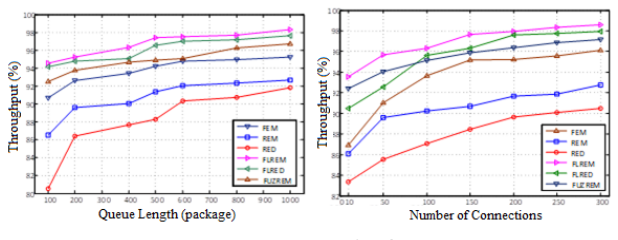
Figure 18. Throughput of AQM mechanisms In all cases, the RED mechanism always has the lowest throughput and the FLREM mechanism always has the highest throughput. This result is due to FLREM mechanism which converges criteria when processing packets to the network node. In addition to the inheritance of the REM mechanism when considering the effect of queue length and load, the FLREM mechanism is also improved by an adaptive fuzzy controller. While RED uses only the length of the queue to determine